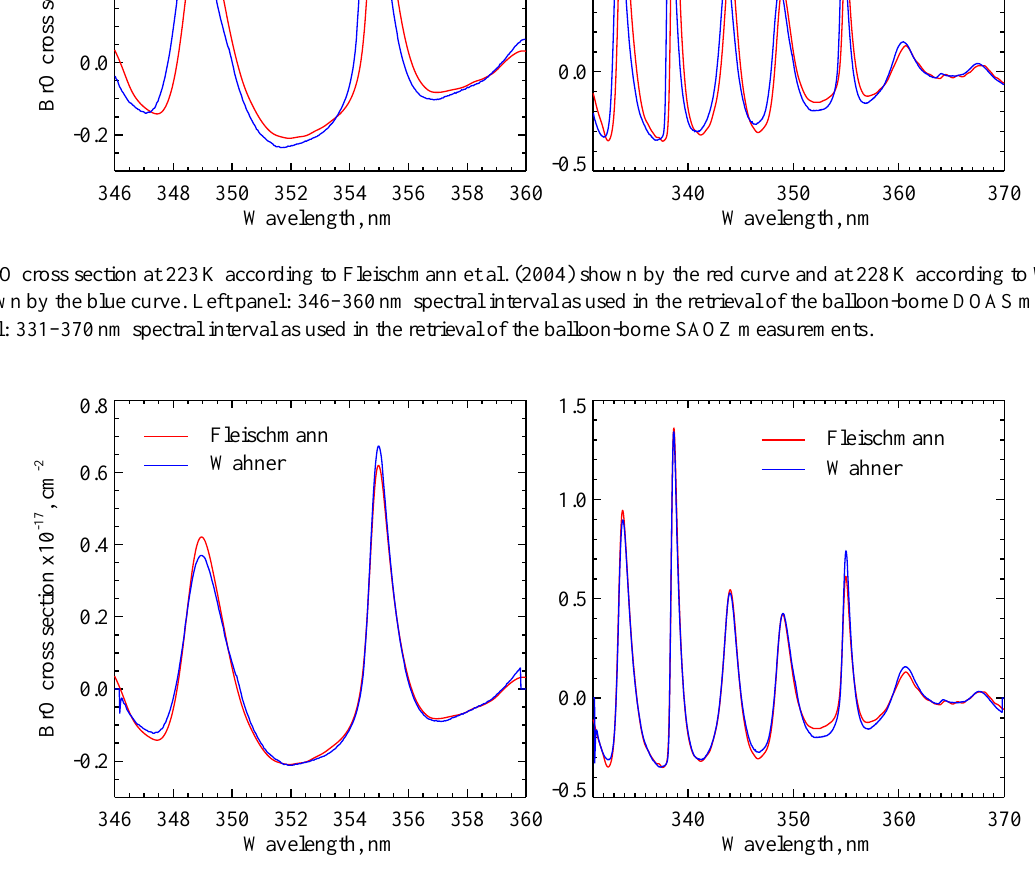
Fig. 15. Same as in Fig. 14 but with the Wahner BrO absorption cross section at 228K (blue curve) fitted to the Fleischmann cross section at 223K (red